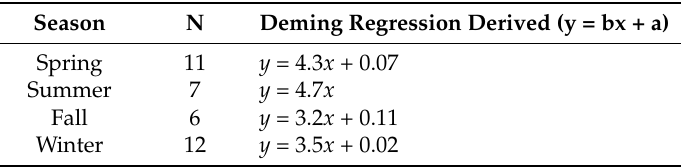
Table 5. Deming regression equations obtained for each season.